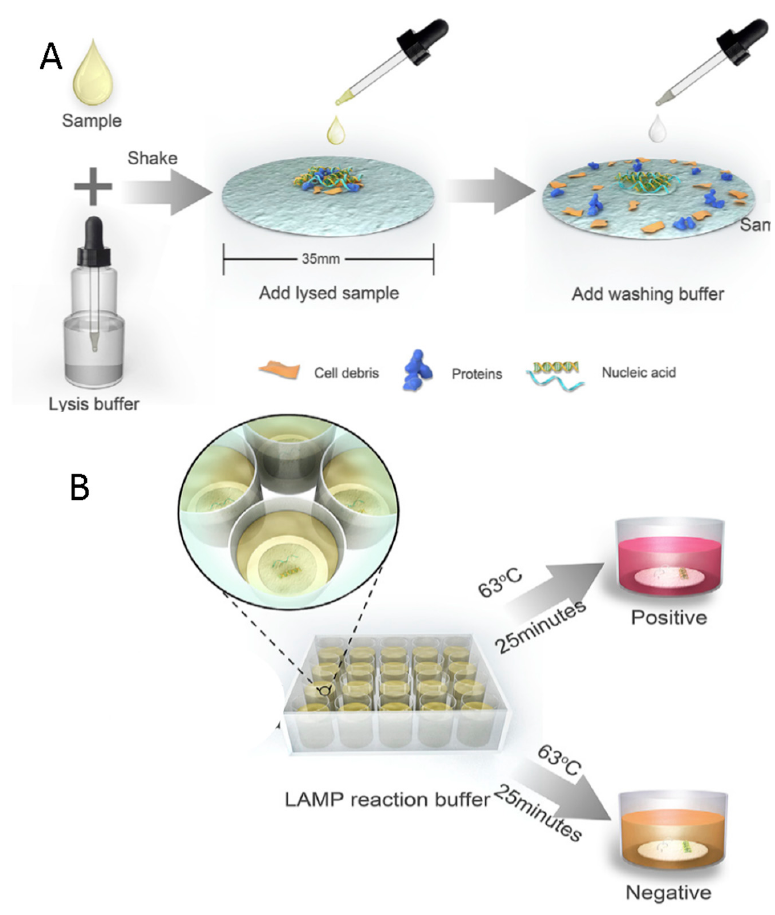
Figure 8. Schematic view of the paper based colourimetric assay proposed by Ye and co-workers: the lysed sample was added to the paper and washed with buffer, while nucleic acid are captured by the paper the contaminant of the lysed sample were eluted with washing buffer by capillary forces ( A ). Second, the sample adding area of the paper was cut and put in a micro-well for subsequent isothermal amplification. The nucleic acid captured on the glass fibre of the paper was directly used as the template for the high-efficiency LAMP reaction, and the results were visible by the naked eye on the basis of color (rose red positive for or brown for negative) ( B ) Modified with permission from [84].